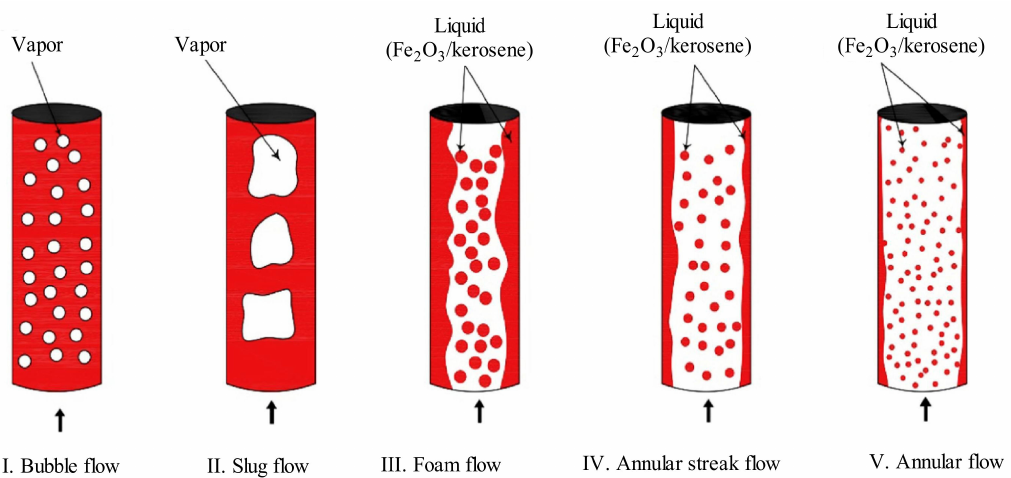
Figure 4. Flow pattern of Fe 2 O 3 /kerosene metal nano-fluid of OHP [80]. Goshayeshi et al.,